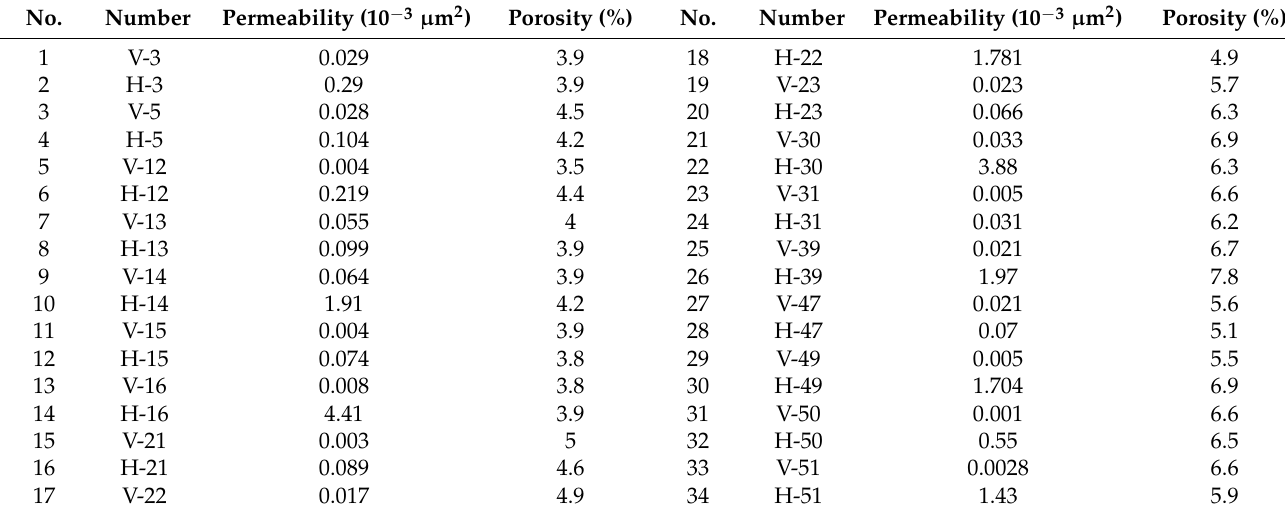
Table 3. Measurement results of shale porosity and permeability.